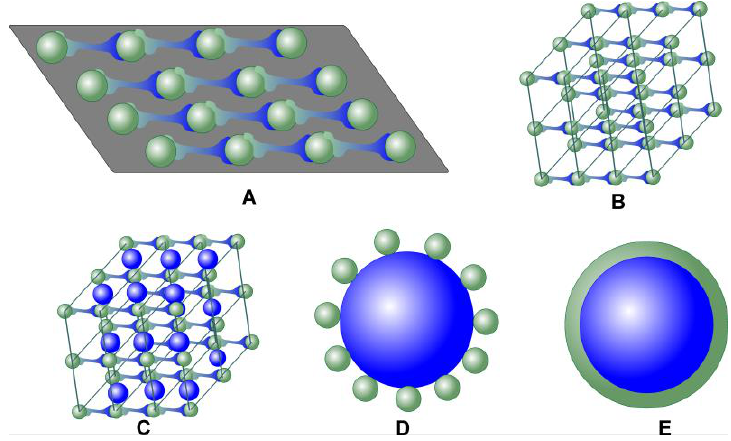
Figure 2. Schematic outline of various MOF structures. For a description, see the text above.